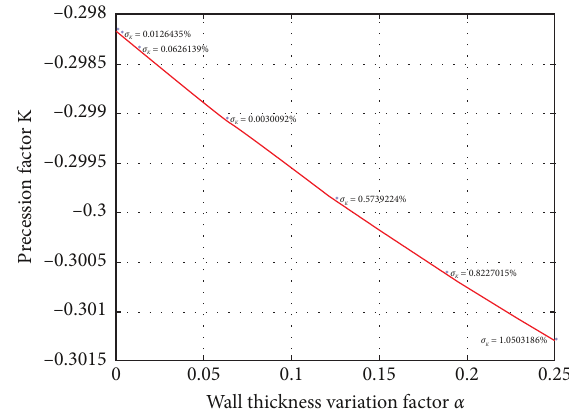
Figure 6: The precession factor with increased thickness of the